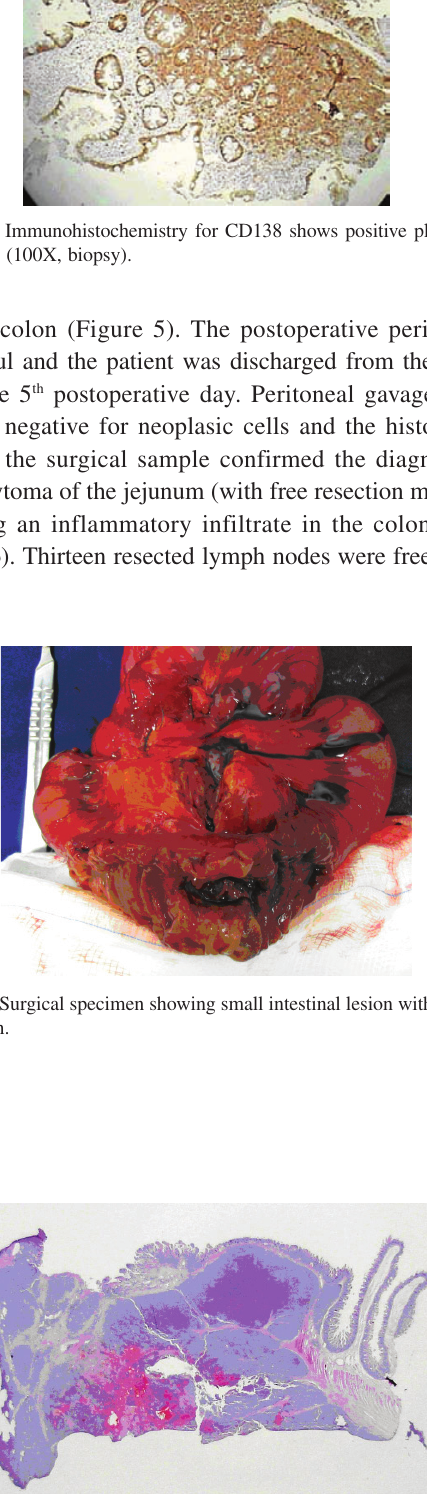
Figure 6 – Thickening of the jejunal wall caused by infiltration of the tumor (optical microscopy, HE,